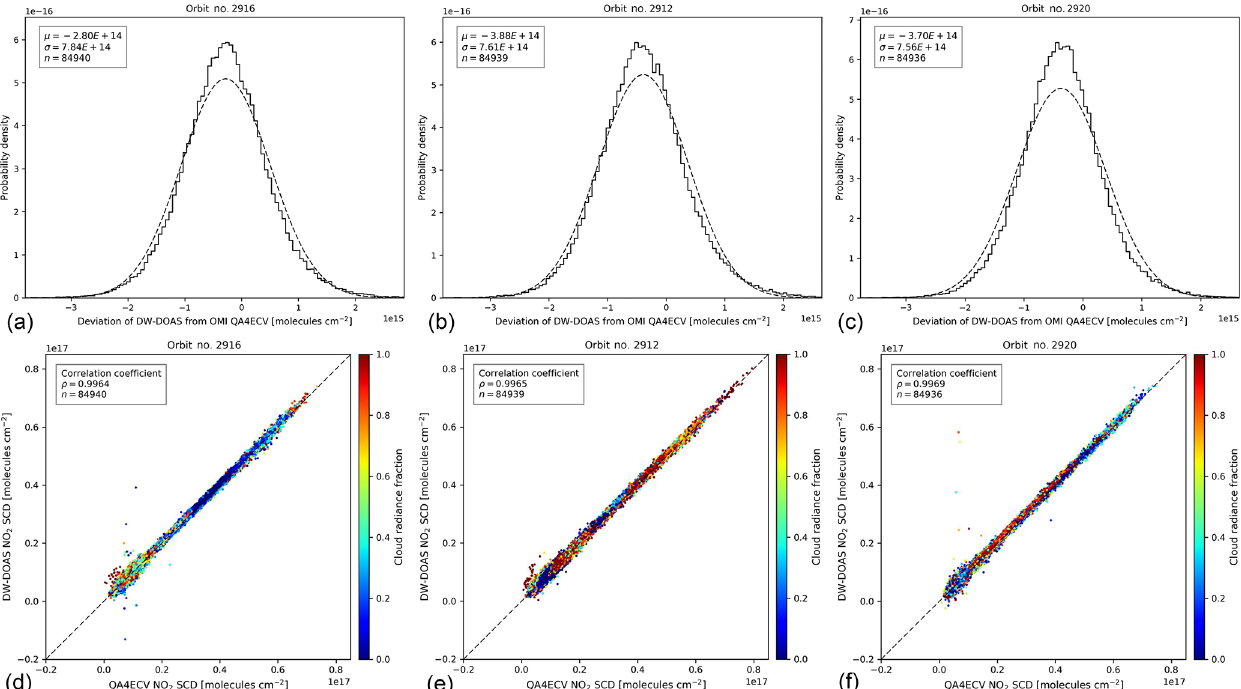
Figure 4. (a, b, c) Distribution of absolute differences between the NO 2 SCDs retrieved by DW-DOAS and QA4ECV for the orbits in Fig. 3, calculated as (QA4ECV – DW-DOAS), and (d, e, f) corresponding correlation